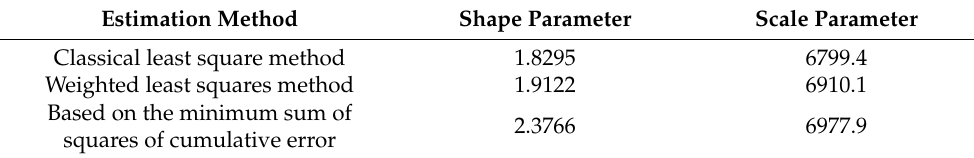
Table 5. Parameter estimates of the Weibull model.